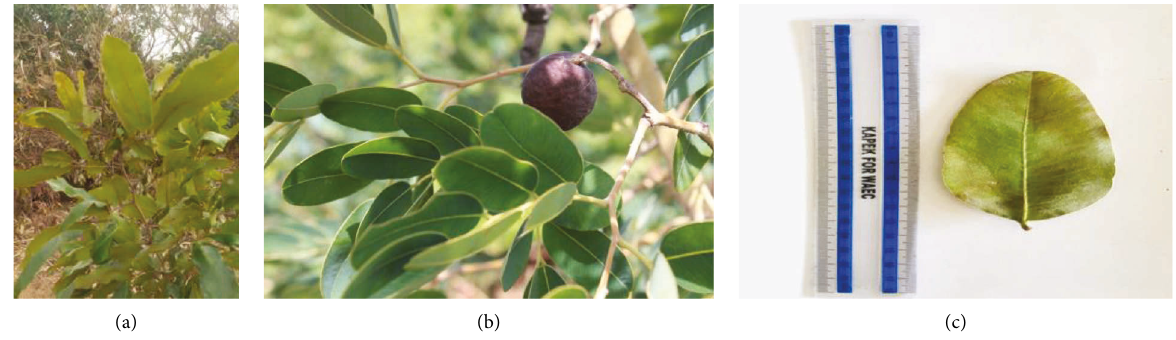
Figure 1: (a) branch (source author), (b) leaves displaying fruit [17], and (c) single leaf (source